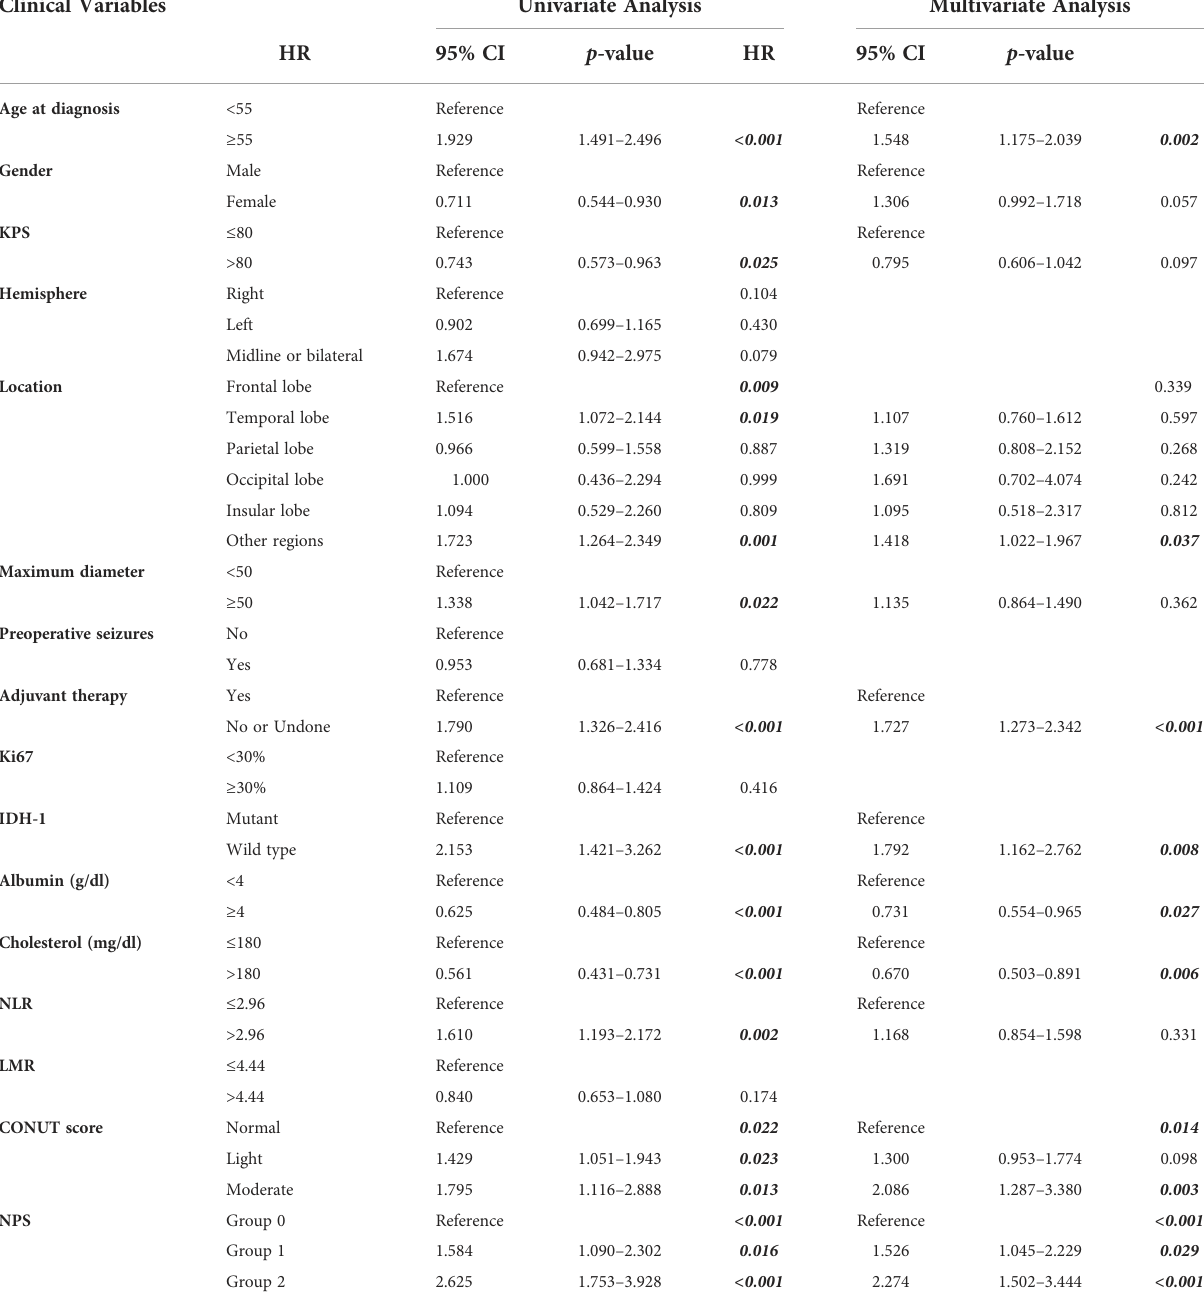
TABLE 2 Univariate and multivariate Cox regression for risk factors predictive of GBMs. Clinical